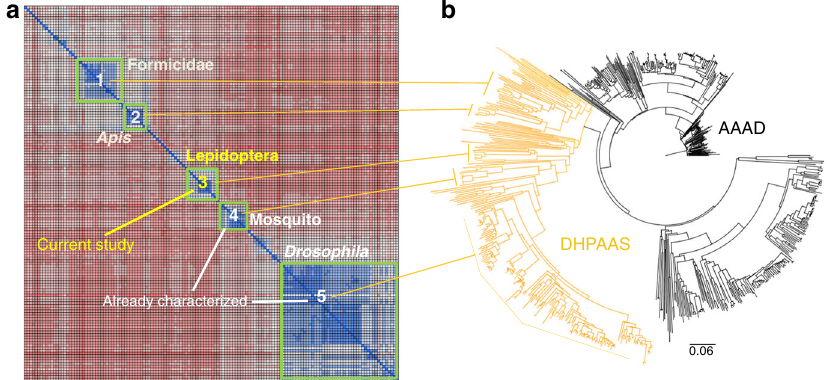
Fig. 4 Phylogenetic classi fi cation of insect DHPAAS sequences. a Sequence similarity matrix of identi fi ed DHPAAS sequences which cluster into fi ve distinct groups. b Phylogenetic tree of AAAD and related DHPAAS sequences. Supplementary Table 3 compares key DHPAAS and DDC active